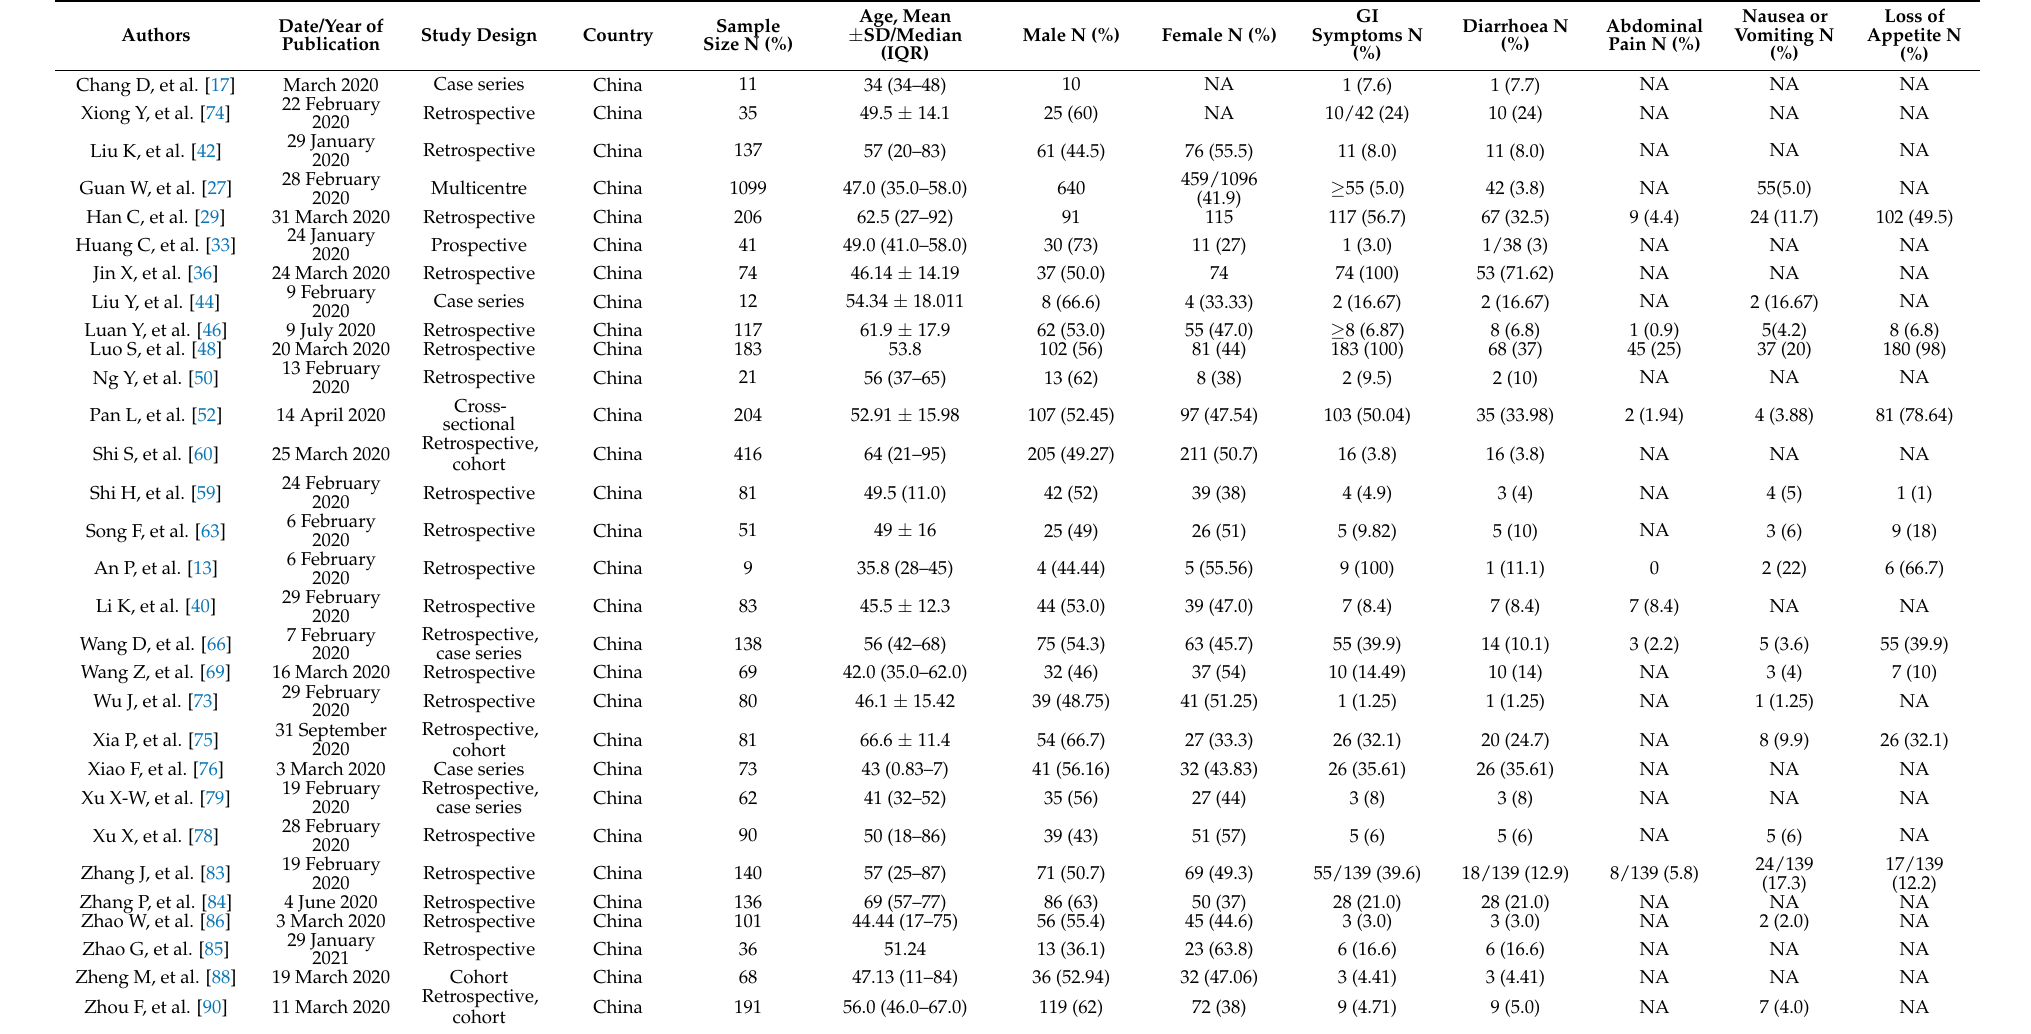
Table 2. Characteristics of 88 studies: summarised overview of their demographic data, epidemiology and clinical